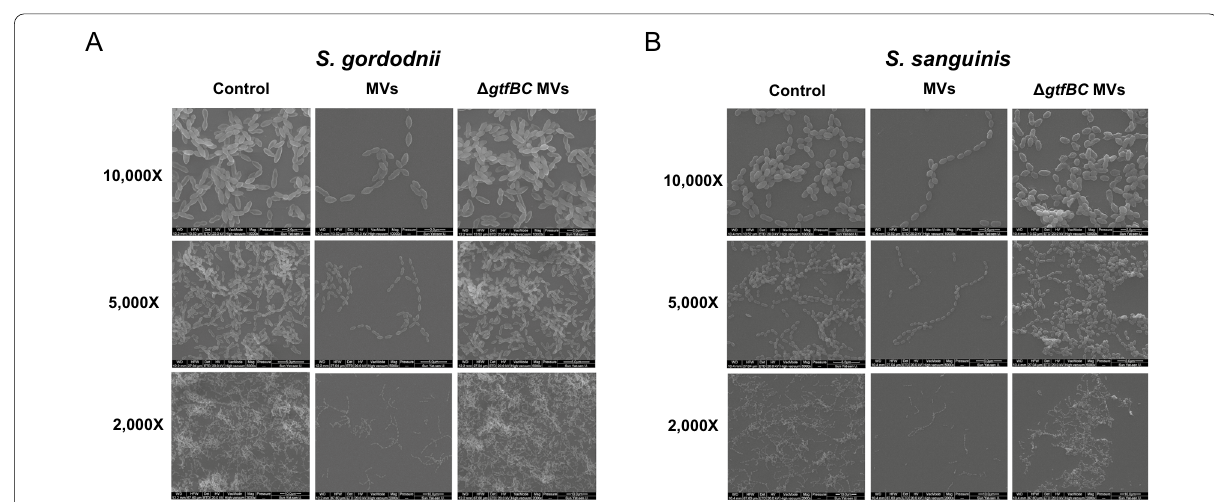
Fig. 2 Morphological characteristics of S. gordonii and S. sanguinis biofilms after treatment with MVs. The bacteria and MVs were co-cultured for 24 h on glass coverslips. Images of S. gordonii and S. sanguinis biofilms were captured using SEM at 2000